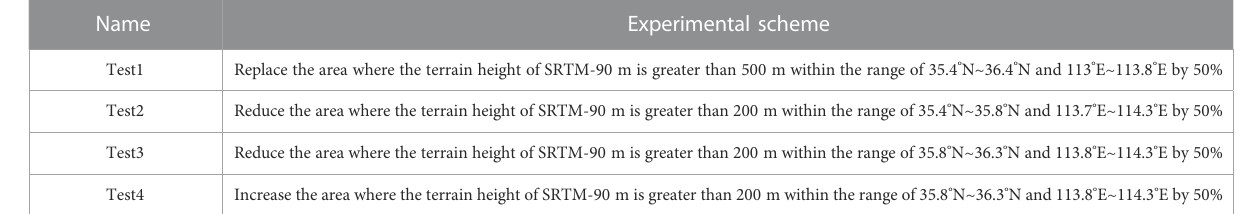
TABLE 2 Schemes for sensitivity experiments with different terrain heights.